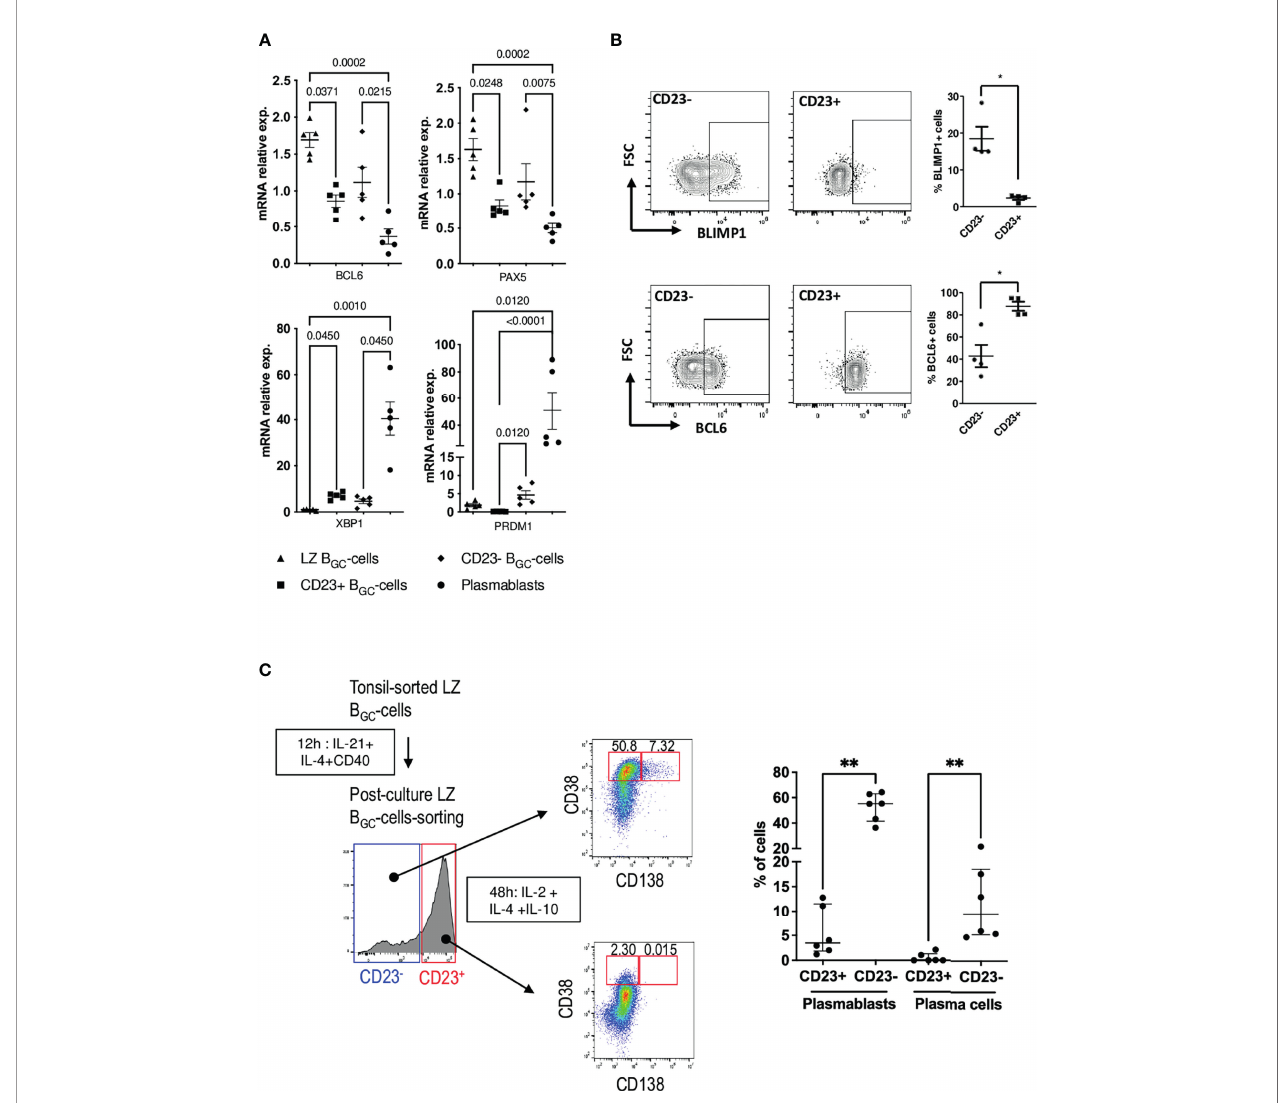
FIGURE 4 | CD23 - LZ B GC -cells contain PB precursors. (A) BCL6 , PAX5 , XBP1 and PRDM1 gene expression after 12 h culture in the presence of IL-4, CD40L and IL-21 for LZ B GC -cells vs . freshly sorted, paired LZ B GC -cells and PBs (one-way Anova & Kruskal-Wallis multiple comparisons test). (B) Flow cytometry analysis of BLIMP1 and BCL6 expression in post-culture CD23+ and CD23- LZ B GC -cells: Left panel, representative fl ow graphs; Right panel, results of four independent experiments (* P ≤ .05; Mann-Whitney test. (C) Post-culture CD23 + and CD23 - LZ B GC -cells were subsequently maintained for 48 h in the presence of IL-2, IL-4 and IL-10 prior to fl ow cytometry analysis, in order to detect CD38 bright CD138 - PBs and CD38 bright CD138 + PCs. Left panel, graphical representation of the experiment and right panel, detected percentages of PBs and PCs for six independent experiments (** P ≤ .01; Mann-Whitney